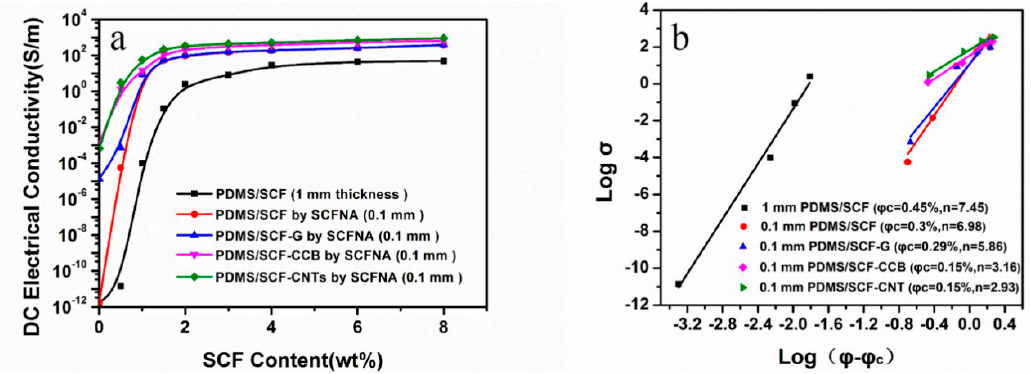
Figure 1. ( a ) Effect of short carbon fiber (SCF) content and sample thickness on the DC electrical conductivity of PDMS composites; ( b ) percolation threshold fitting results. Table 1. Comparison of electrical conductivity of PDMS/SCF composites as the effects of sample thickness and a second nanofiller. The thickness of PDMS/SCF composites was reduced from 1 to 0.1 mm by the SCFNA method, the second filler (graphene (G), superconductive carbon black (CCB), or carbon nanotube (CNT)) content is 1 wt %. SCF (wt